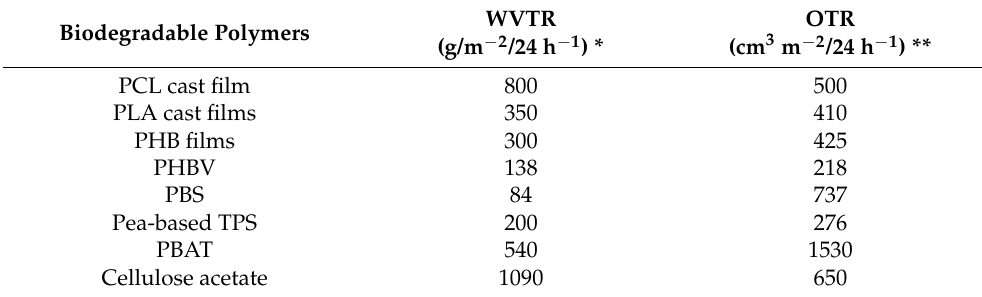
Table 5. Water vapor transmission rate [WVTR] and oxygen transmission rate [OTR] of certain biodegradable plastics